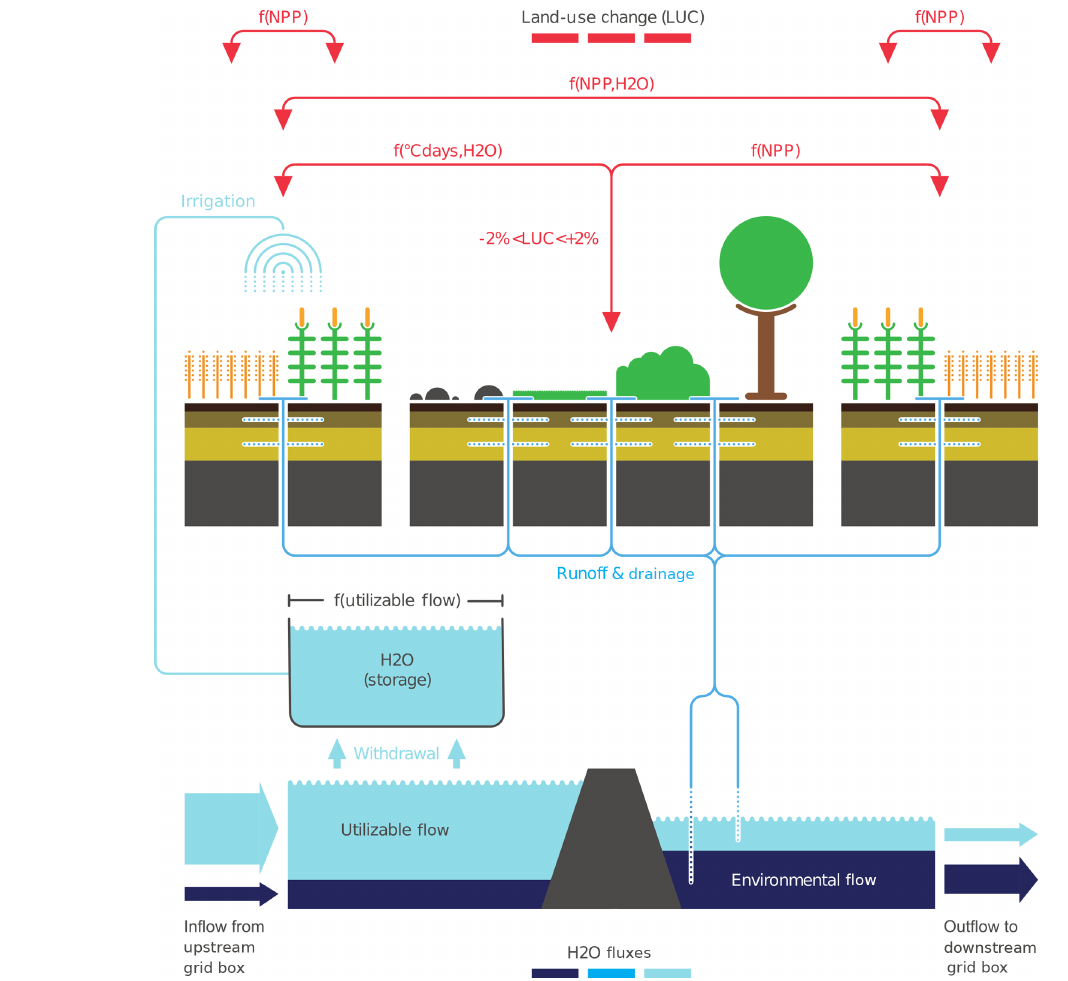
Figure 1. Newly implemented processes. Cultivation scheme . Within a given grid box and year, up to 2.2% of the area can be converted from natural vegetation, pasture and bare soil to cultivated area. The rate at which the extent of croplands increases or decreases is modeled as a function of the crops’ net primary productivity (NPP) in the case of rainfed crops, and of the available water (H 2 O) and the length of the growing season ( ◦ C days) for irrigated crops. Areas can also be transferred from irrigated to rainfed crops and vice versa. This transfer is modeled based on the plants’ NPP and the available water in order to facilitate the expansion of the more productive technique (rainfed or irrigated) and to minimize the loss of agricultural output arising from decreasing irrigation water supplies. In a given grid box either C 3 or C 4 crops are being grown, depending on which of the types has the higher productivity under the present climate conditions as measured by the previous year’s NPP. Water management scheme . On the terrestrial surface, all water that is not stored in the soil’s pore spaces or evaporated and transpired forms runoff and drainage. These constitute the lateral inflow into the river within a given grid box, from where water is accessible for agricultural use. About one-third of the runoff and drainage that enters the river may not be withdrawn within any of the downstream grid boxes as it is required to sustain the ecological stability of the river, i.e., the environmental flow. The flow that surpasses these requirements, i.e., the utilizable flow, can be withdrawn, stored within a reservoir and used for irrigation. The size of this